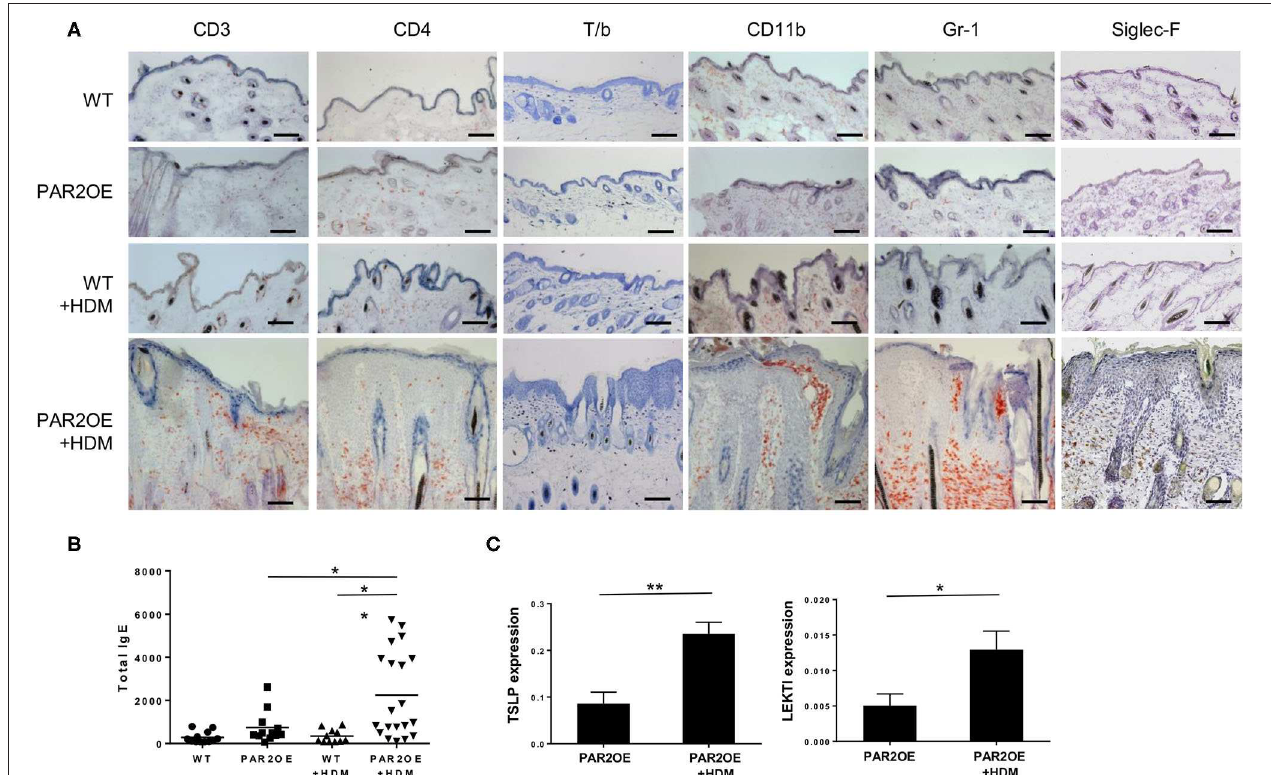
FIGURE 5 | The eczematous skin lesions in HDM-treated PAR2OE mice display immunological characteristics of atopic dermatitis. All samples derive from 14-week-old PAR2OE and WT mice, treated with HDM or vehicle for the last 6 weeks. (A) Representative toluidine blue (T/b), CD3, CD4, CD11b, Gr-1, Siglec-F immunohistochemistry stainings. Bars represent 200 µ m. (B) Total-IgE in the blood of 14-week-old PAR2OE and WT mice, after 6 weeks of HDM or vehicle treatment. Bars represent the mean ( n = 12–20 mice). (C) Expression of TSLP and LEKTI by qPCR in whole skin samples ( n = 5 mice per group). * p < 0.05, ** p < 0.01, (unpaired Student’s t-